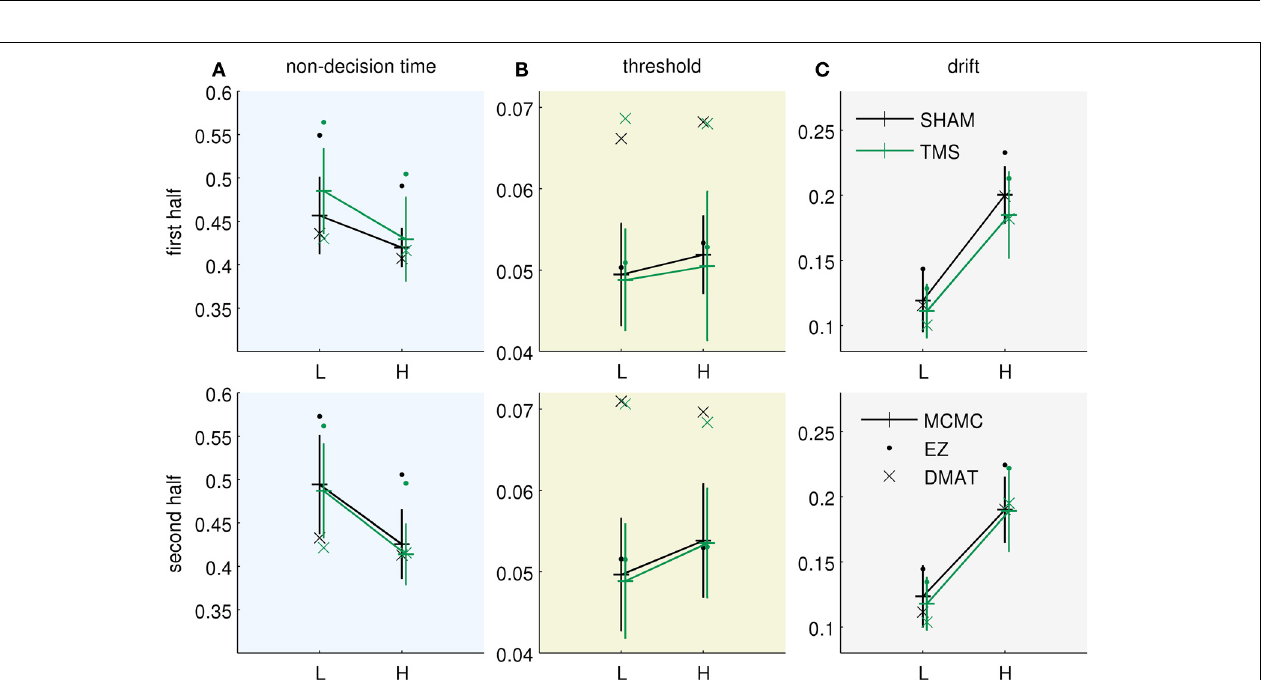
evidence (low noise) condition, TMS—TMS applied over dlPFC, SHAM—SHAM stimulation instead of TMS. Error bars for MCMC results correspond to double standard deviation of posterior samples. The two rows correspond to the two subsequent halves of the experiment. (A) Fits of the non-decision time T nd , (B) fits of the internal uncertainty ˆ σ , and (C) fits of the noise uncertainty σ . All methods allow for qualitatively similar conclusions, see text.